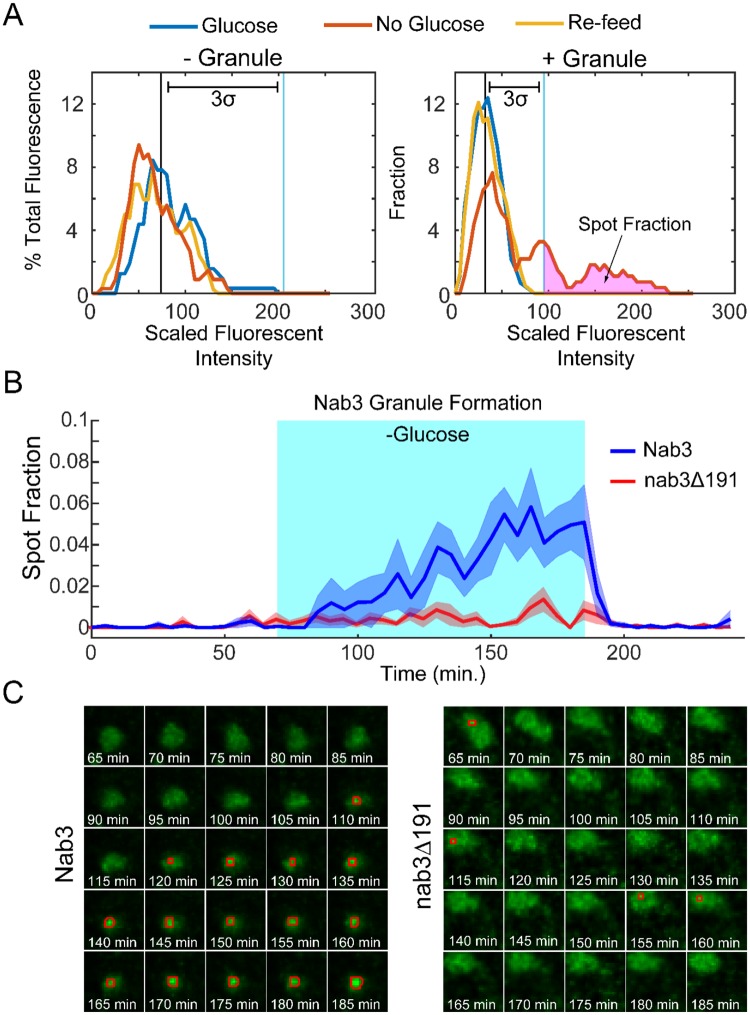
The Nab3 granule is reversible and dependent upon Nab3’s PrLD.A) Illustrative histograms for a single cell scored as lacking (left) and a single cell scored as containing (right), a GFP-Nab3 granule. For each cell, fluorescence over 1 hr growth in glucose (blue peak) was used to calculate a baseline mean and standard deviation. Fluorescent intensity (scale of 0–255, bins of 5) is plotted versus % of fluorescence intensity that each bin is of the total. The amount of fluorescence present more than 3σ above the mean was used to calculate the spot fraction. B) Time course of accumulation of fluorescence in the spot fraction for GFP-Nab3 (blue) and GFP-nab3Δ191 (red). Cells were analyzed by real time fluorescence microscopy in a microfluidic device that allowed the exchange of glucose-containing and glucose-free media. Cells were imaged for 60 min prior in glucose, then switched to no glucose for 2 hours (turquoise area), followed by refeeding with glucose for an hour. The average spot fractions (lines) and standard deviations (shaded areas) for GFP-Nab3 and GFP-nab3Δ191cells were calculated over the time course. C) Time course microscopy of a single nucleus from GFP-Nab3 (left) and GFP-nab3Δ191 (right) starting 5 min after glucose-free conditions (t = 65’). Pixels with fluorescence >3σ for each cell are boxed in red. Cells with Nab3 lacking the PrLD generally did not form granules, but, as seen in this example, those that scored positively show sporadic, small spots, in contrast to the robust and persistent spots formed in wild type Nab3.